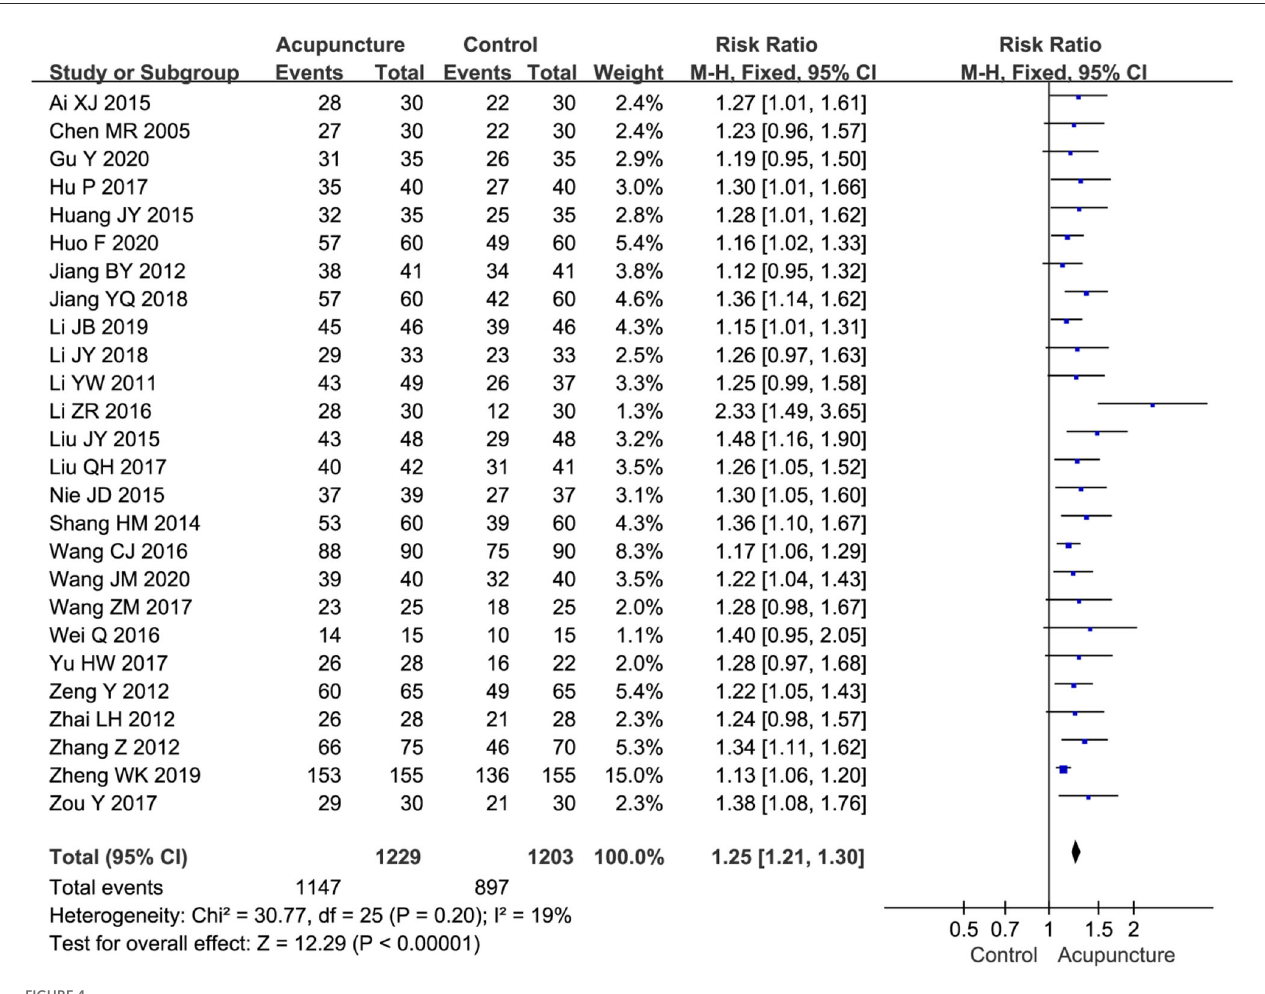
FIGURE4 A Forest plot for total effective